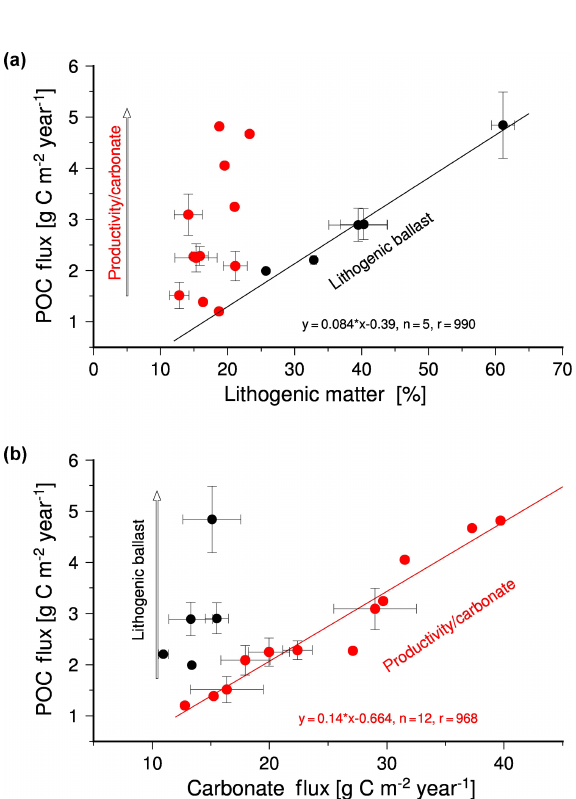
Figure 8. Organic carbon fluxes (POC) versus lithogenic matter content (a) and carbonate flux (b) . The red and black circles in- dicate trap sites at which the annual mean lithogenic matter content is <and >25%, respectively.